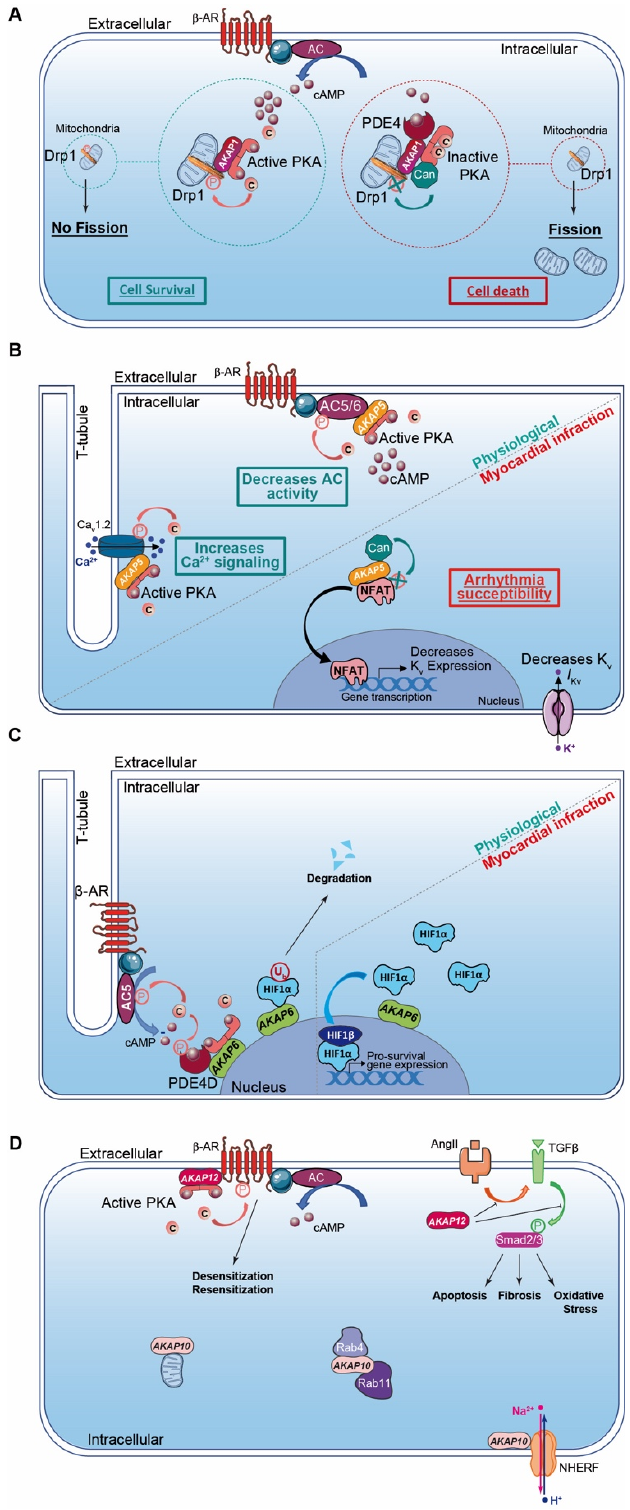
Figure 2. Cardiac AKAPs and cAMP signaling compartmentalization in myocardial infarction (MI). ( A ) AKAP1 coordinates at the mitochondria a cardioprotective macrocomplex that mediates phosphorylation of Drp1 by anchored PKA, which inhibits mitochondrial fission and leads to cell survival (left). This process is counterbalanced by CaN recruitment on AKAP1 signaling complex, which, in contrast, favors Drp1 dephosphorylation and mitochondrial fragmentation (right). ( B ) Role of cardiac AKAP5 under physiological conditions and after MI. In cardiomyocytes, AKAP5- anchored PKA mediates direct AC5 and AC6 phosphorylation to inhibit AC activity and cAMP